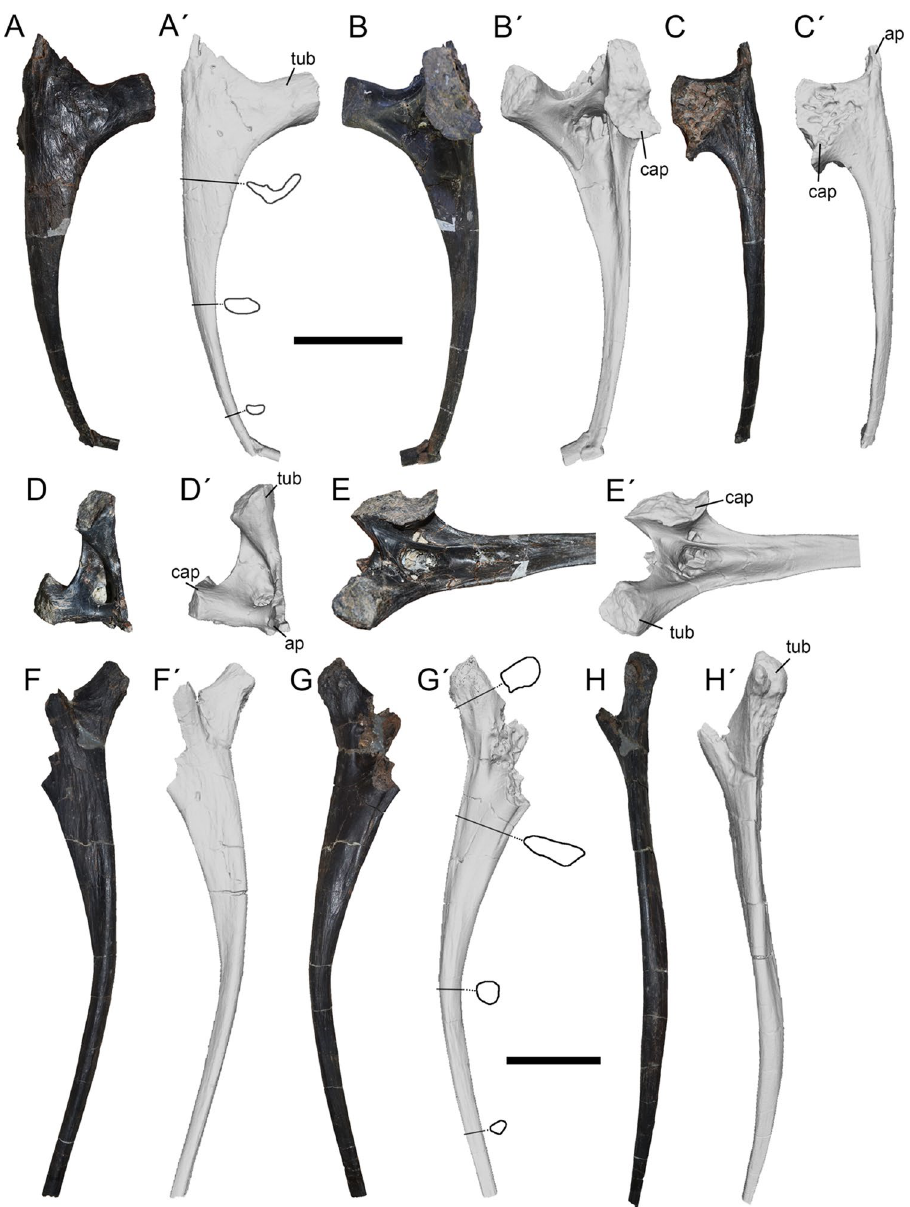
Figure 10. Seventh ( A – E ) and eighth ( F – H ) cervical ribs of Maip . Seventh cervical rib in lateral ( A, A´ ), medial ( B, B´ ), ventral ( C, C´ ), anterior ( D, D´ ) and posteromedial ( E, E´ ) views. Eighth cervical rib in lateral ( F, F´ ), medial ( G, G´ ) and dorsal ( H, H´ ) views. Scale bars: 5 cm. Abbreviations: ap, anterior process; cap, capitulum; tub,